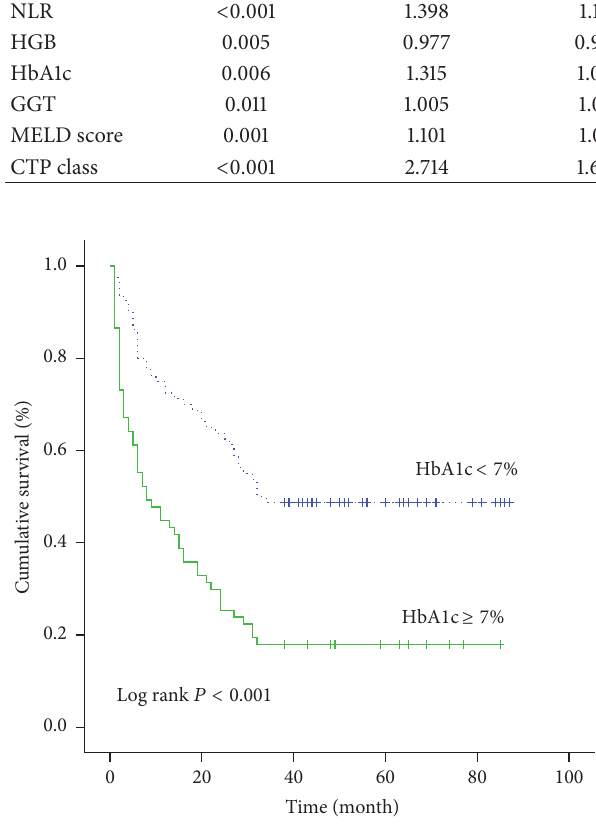
Figure 2: The cumulative survival rate of patients in stratified NLR groups.